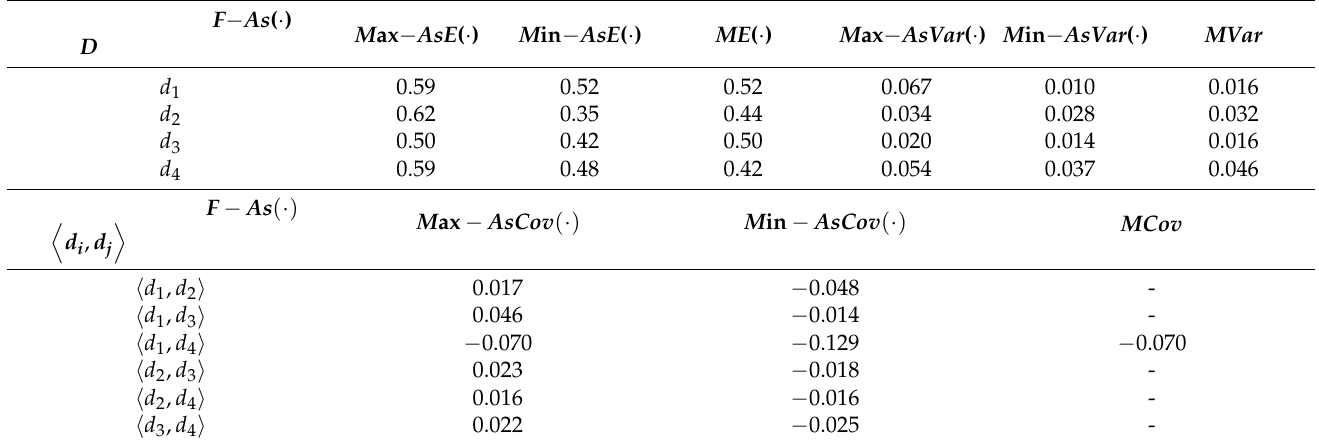
Table 6. Maxima and minima associated and monotone statistical